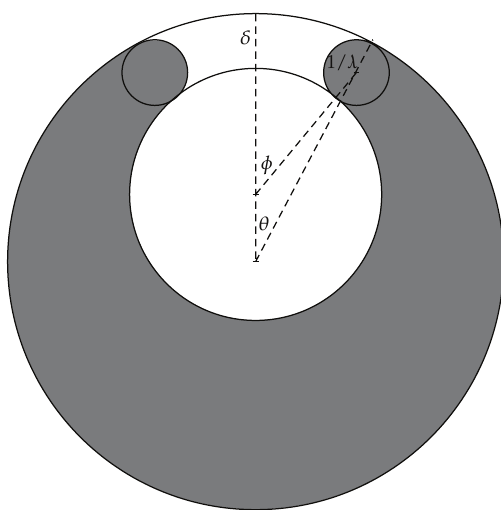
Figure 2: Nonconcentric Annulus with angles φ and θ